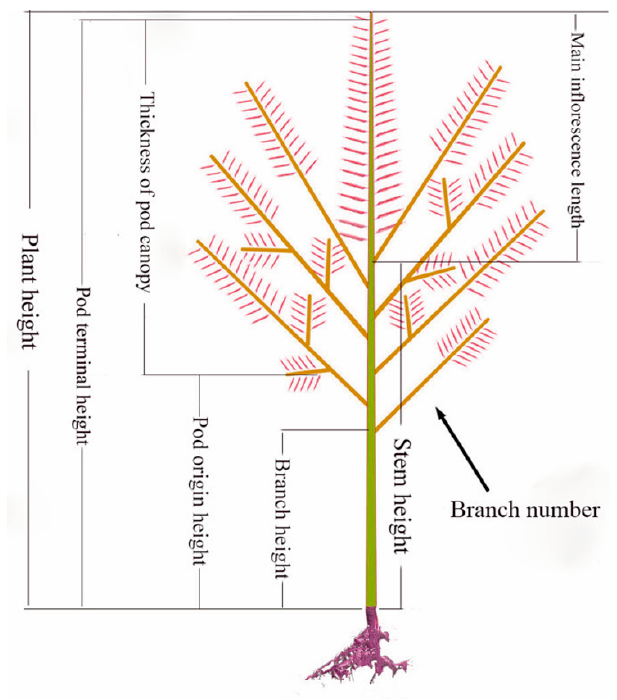
Figure 1. The thickness of pod canopy (TPC) related to architecture traits in Brassica napus .